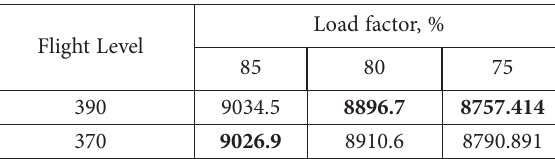
Table 9. Trip fuel in kg, 3000 km flight, ‘New’